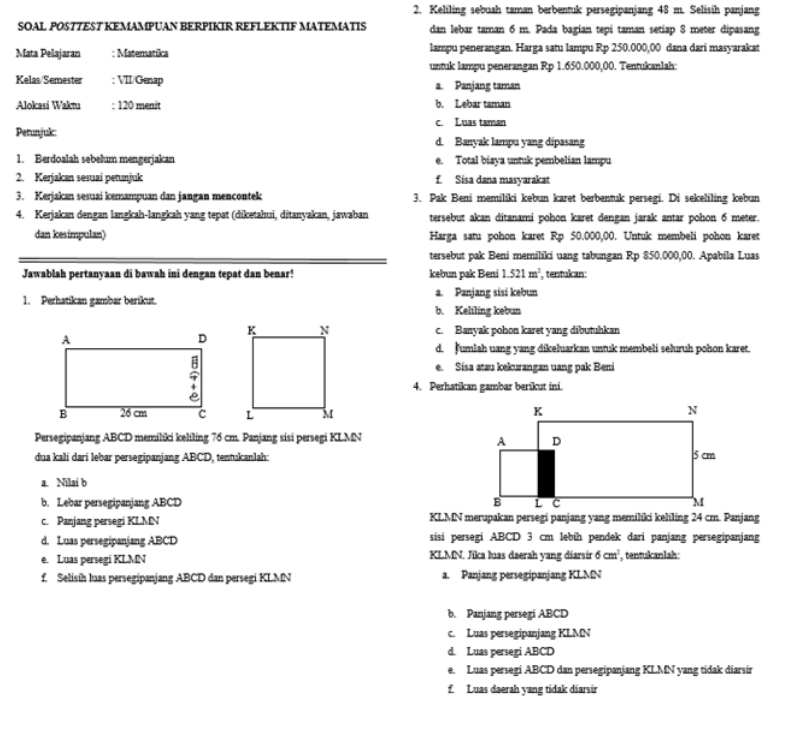
Fig. 2. Posttest question for the experiment and control